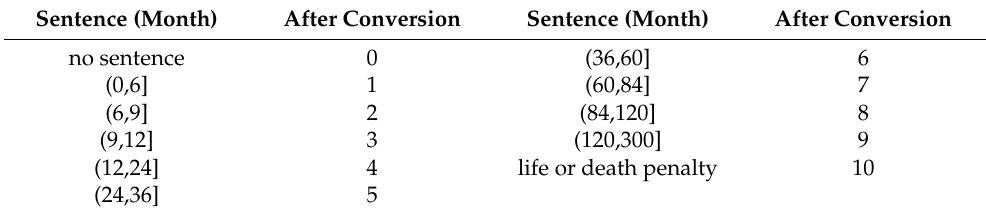
Table 3. Sentence conversion